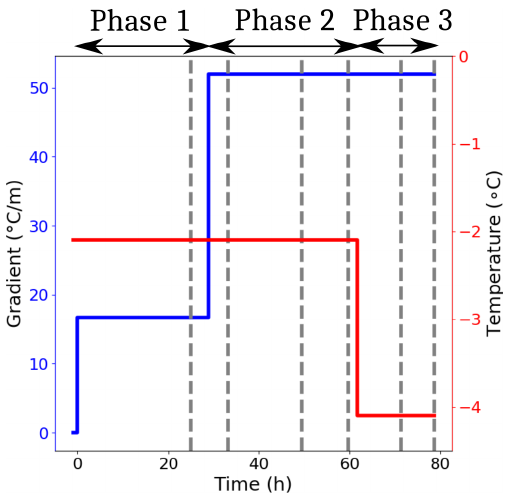
Figure 2. Evolution of the mean temperature and downward tem- perature gradient imposed on the